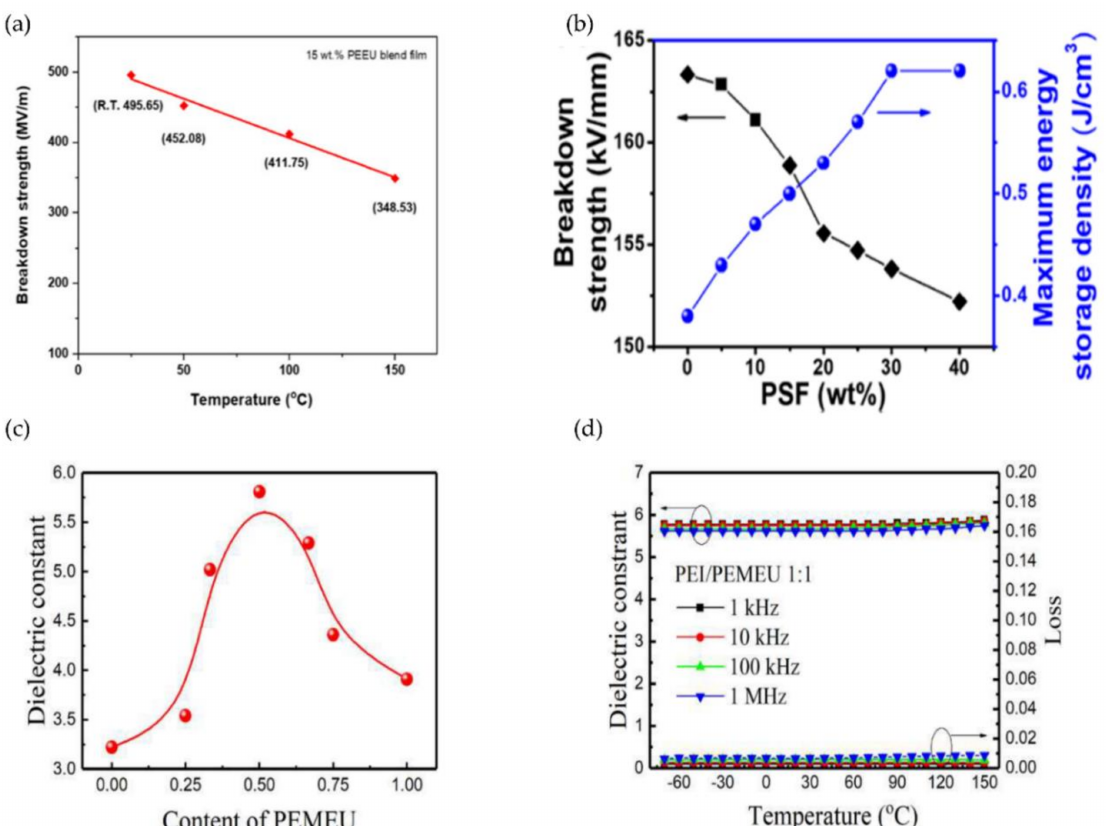
Figure 3. ( a ) Point line diagram of breakdown strength with temperature; ( b ) Breakdown strength and energy storage characteristics of PI/PSF films; reprinted with permission from [56,57]. Copyright (2021), Wiley. ( c ) the relationship between dielectric constant and blend composition (weight ratio of PEI: PEMEU) at 1 kHz; ( d ) The dielectric properties of a 1:1 mixture of PEI and PEMEU vary with temperature at different frequencies. Reprinted with permission from [62]. Copyright (2019),